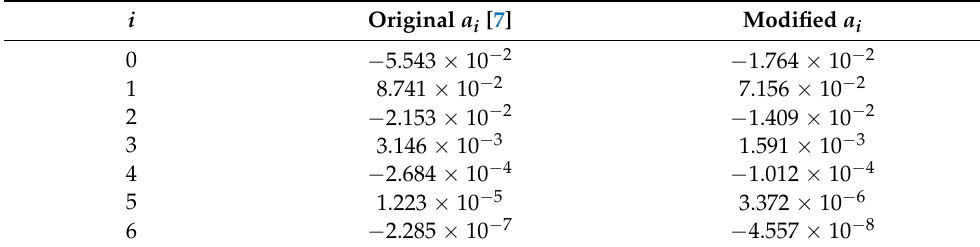
Table 1. Coefficients for the polynomial fitting of optimal θ .